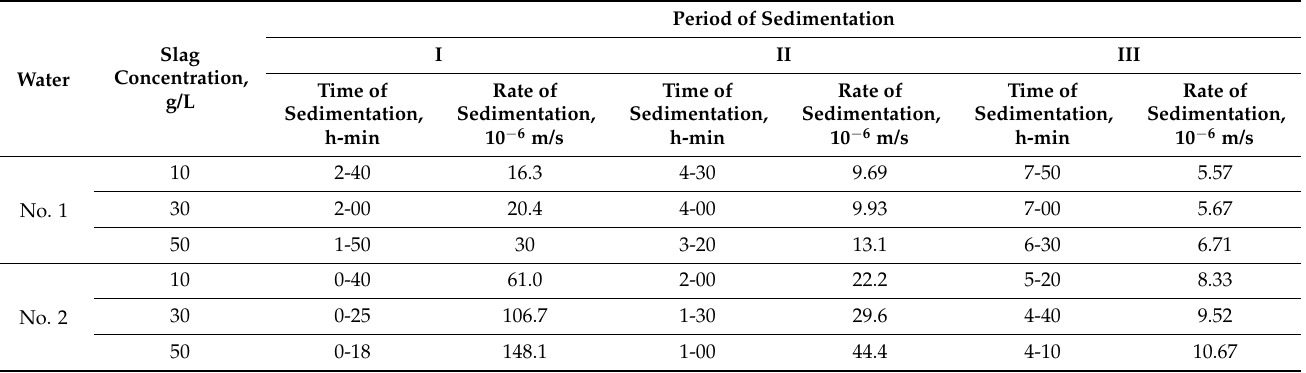
Table 19. Time and rate of sedimentation of slag particles in water dispersed medium of different hardness with plasticizer without ultrasonic processing.